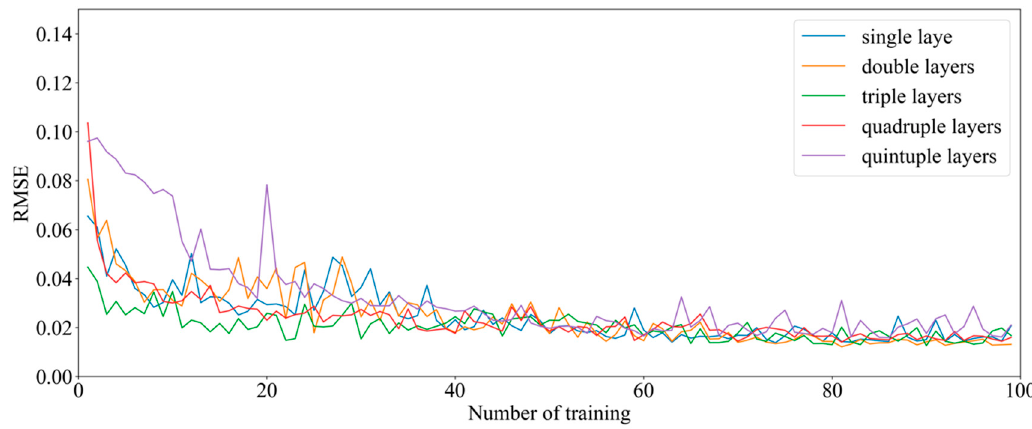
Figure 10. The test error under different layers.